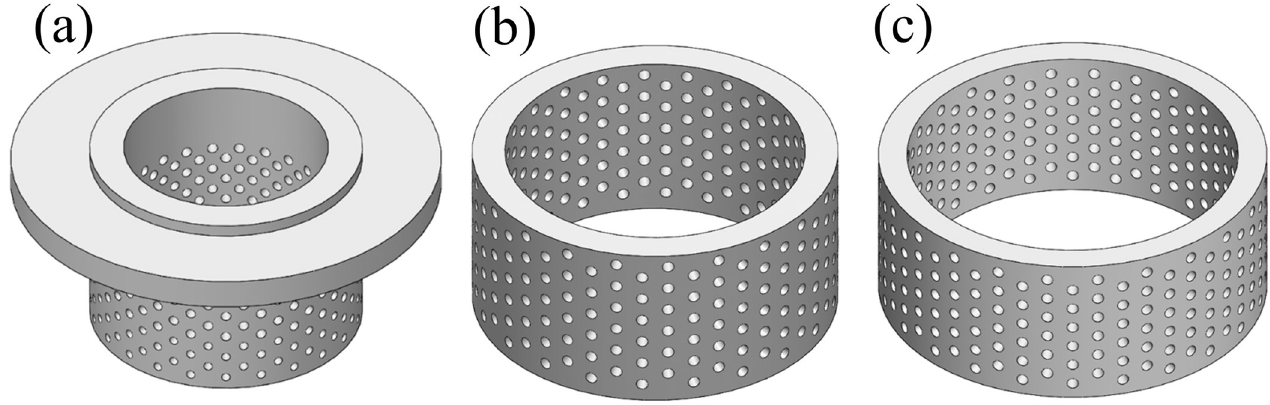
Fig 2. Multilayer sleeve. (a) inner sleeve. (b) middle sleeve. (c) outer sleeve.